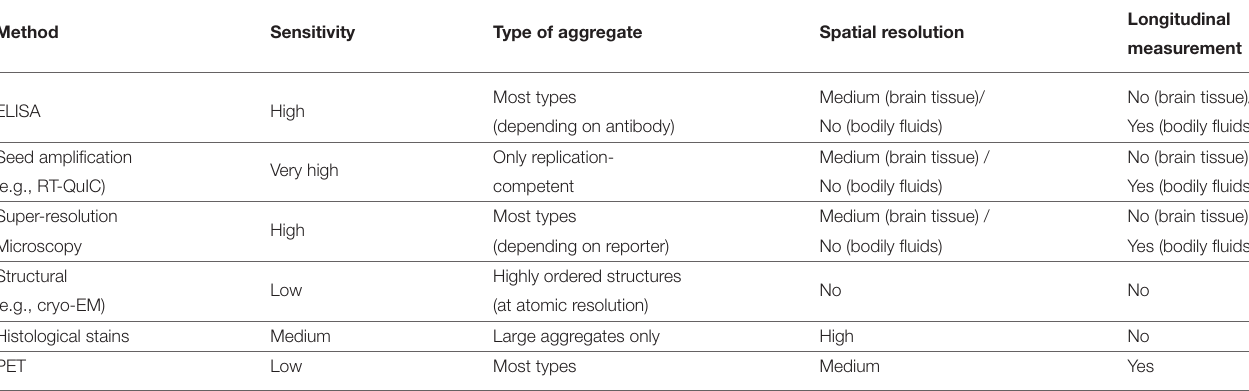
TABLE 1 | Comparison of a selection of methods for in vivo measurements of aggregate